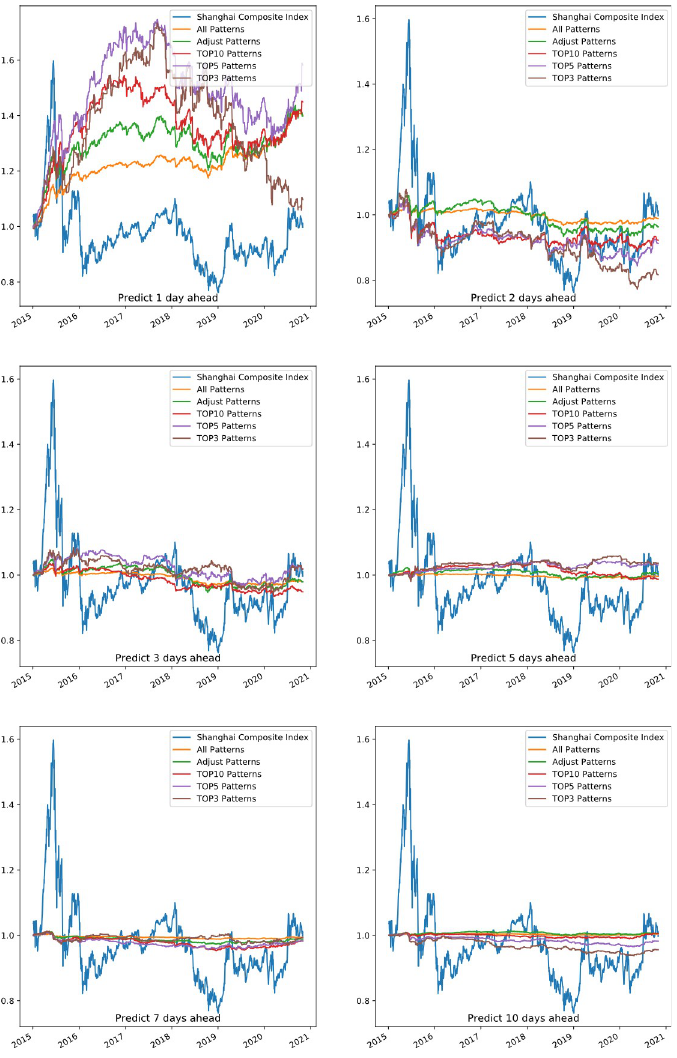
Fig 9. Portfolio return performance of three-day patterns predicting 1, 2, 3, 5, 7, 10 days ahead.